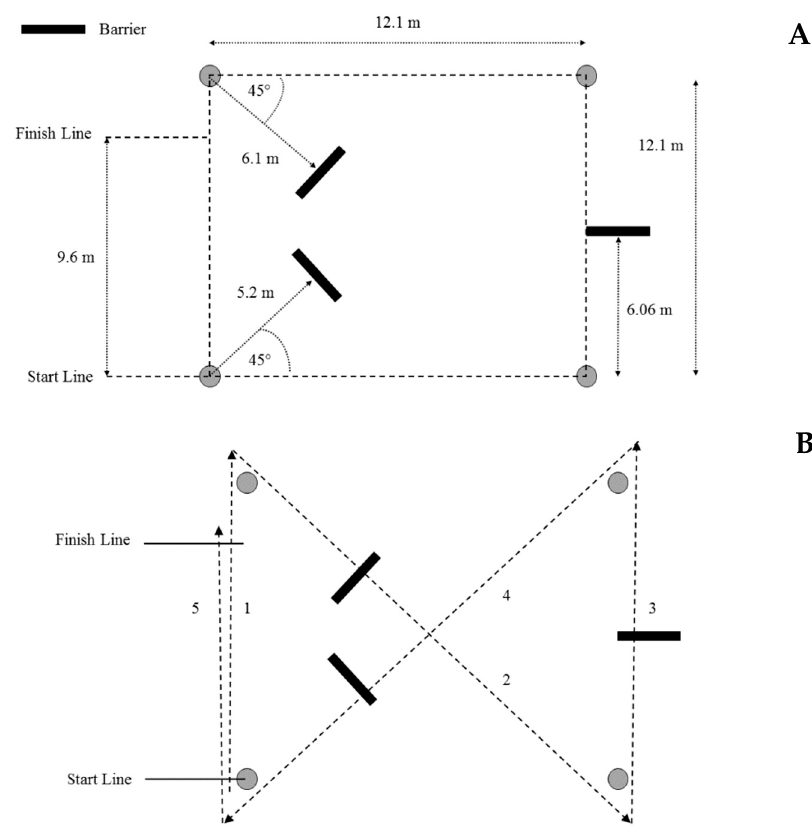
Figure 1. ( A ) The dimensions for the 75-yard pursuit run (75PR) in meters and ( B ) the running direction (numbered in order) for the 75PR.